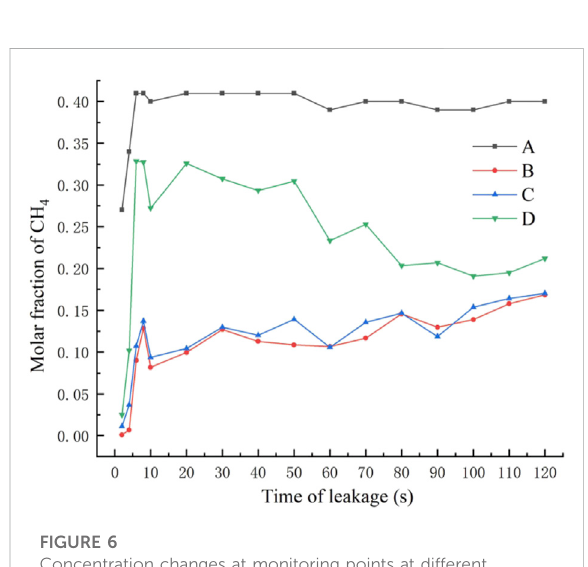
FIGURE 7 Hazard distance of the lower limit of methane explosion at different